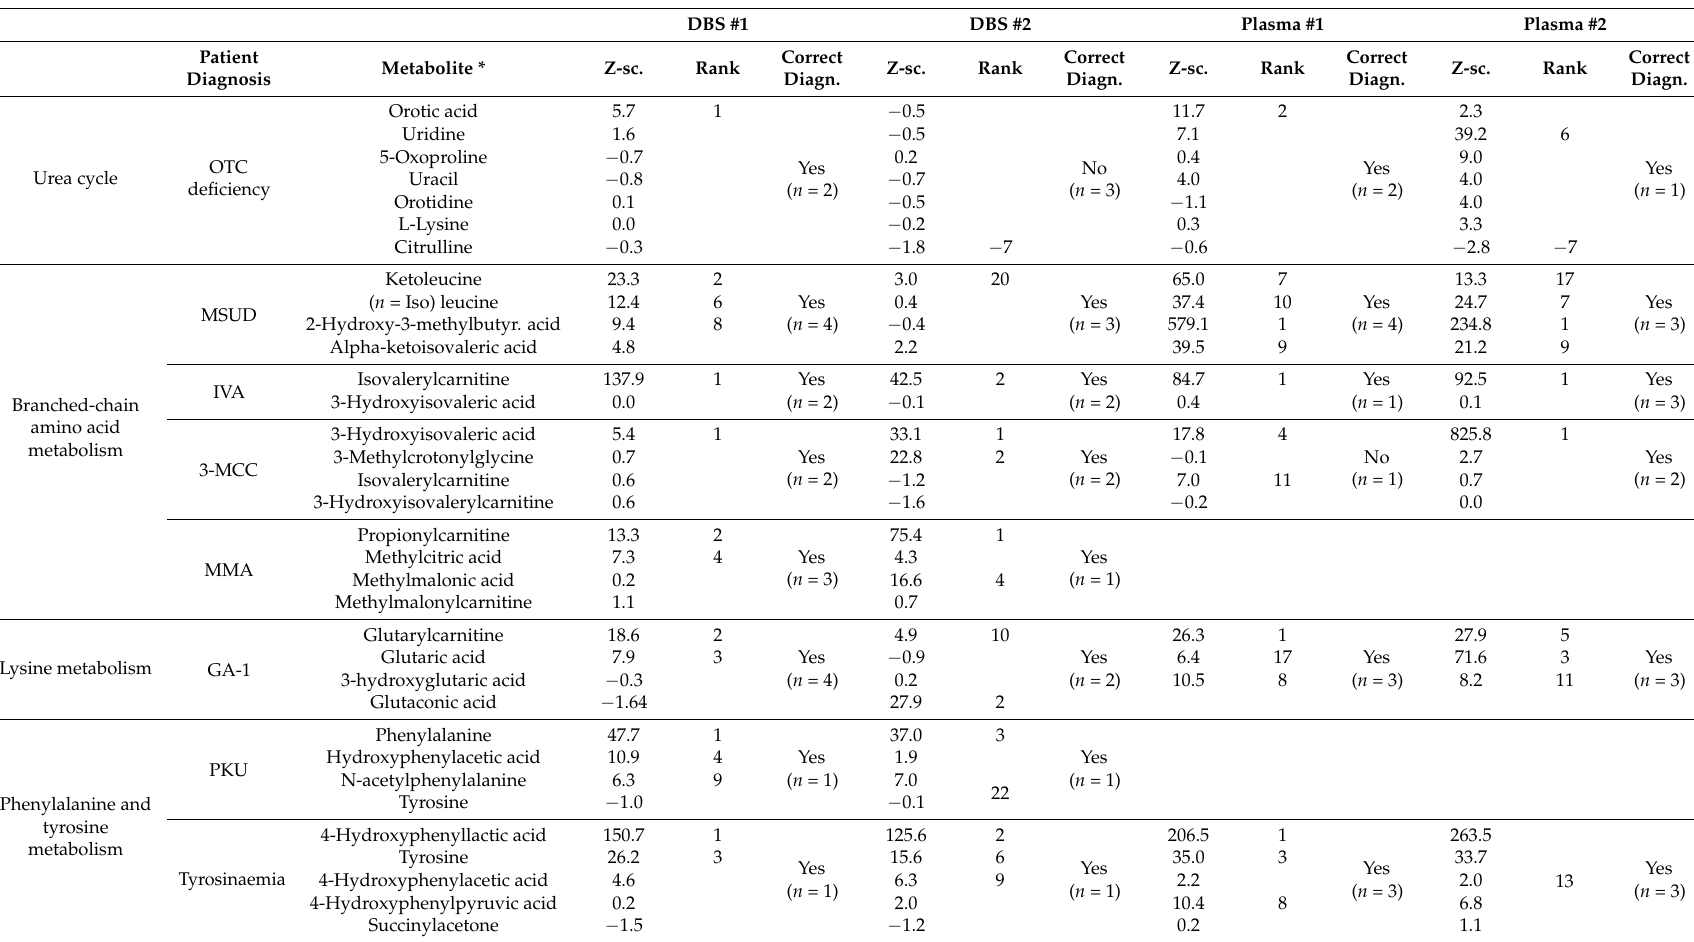
Table 4. Assigned most probable diagnoses based on metabolite Z-scores in DBS and